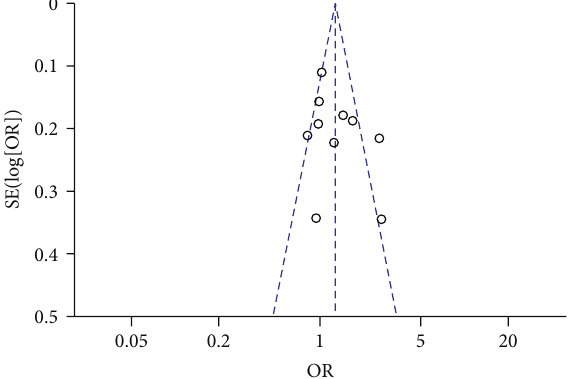
Figure 7: Funnel plot of studies conducted on the association between rs1137101 (R223Q) and T2DM risk (G >